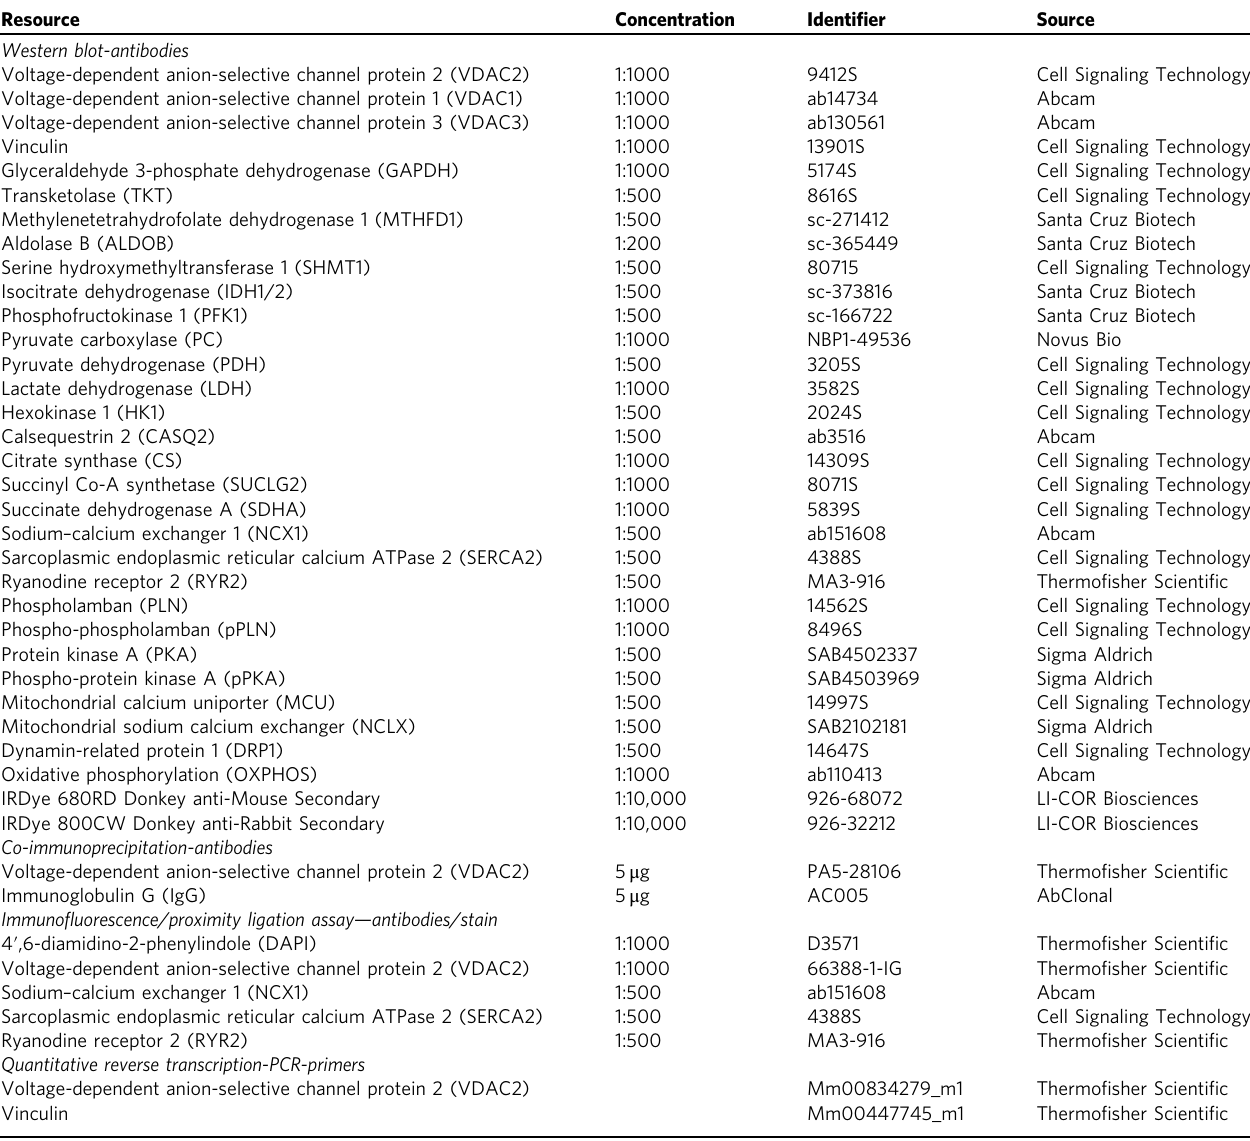
Table 1 List of antibodies used. Resource